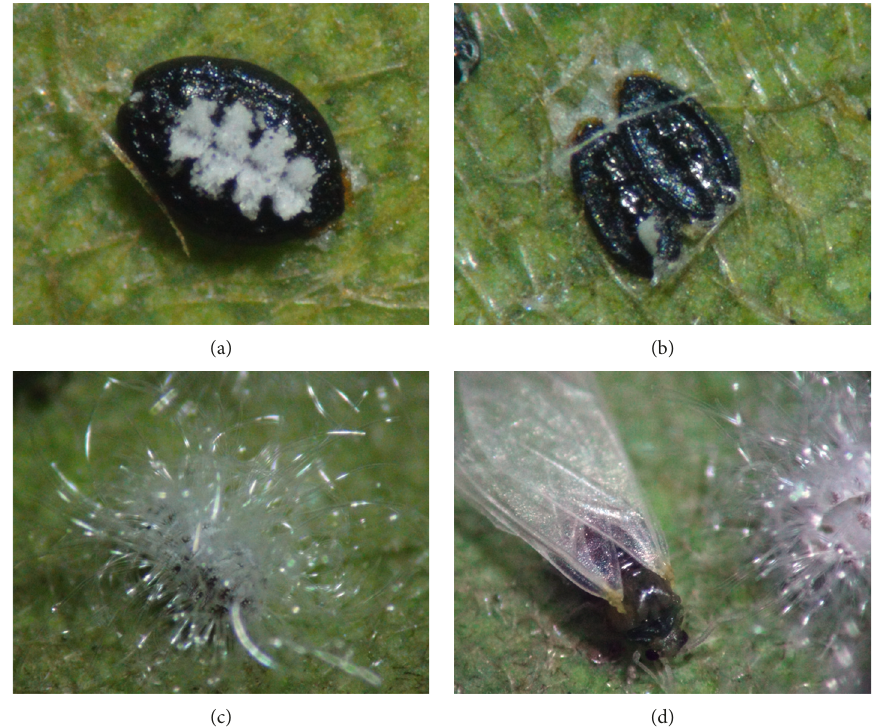
Figure 1: Neothoracaphis glaucae on the undersides of leaves of Quercus glauca found in Shinkiba, Tokyo, Japan: (a) an L-type apterous adult (20 January 2014); (b) two S-type apterous adults (20 January 2014); (c) a fourth-instar nymph to be alate (20 November 2013); (d) a teneral alate sexupara with a cast-off skin (20 November